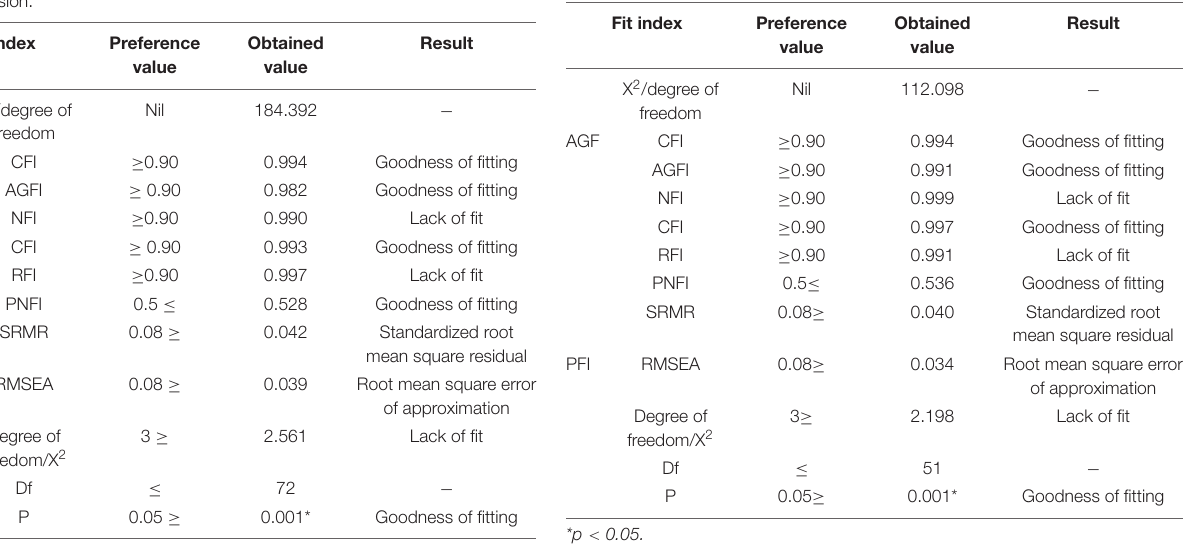
TABLE 6 | Goodness-of-fit indices of the EBs before revision.